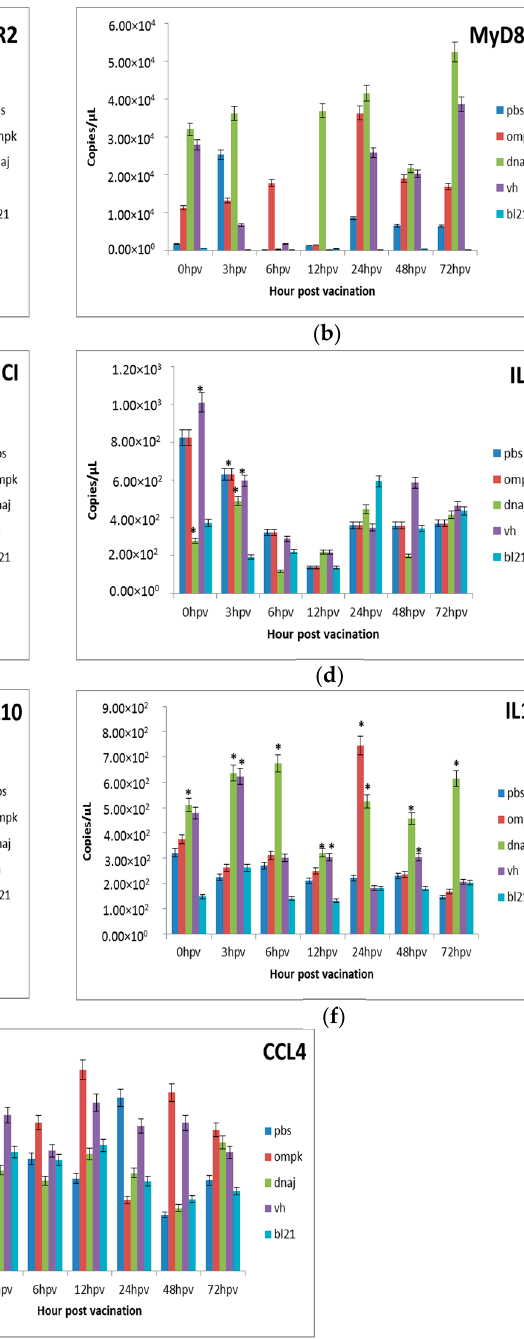
Figure 5. Comparative expression profiles of the antigen recognition-related genes ( a ) TLR2, ( b ) MyD88, ( c ) MHCI and pro-inflammatory cytokines ( d ) IL8, ( e ) IL10, ( f ) IL1ß, ( g ) CCL4 in the spleen of juvenile seabass after vaccination. Juvenile seabass were injected with 10 7 CFU / mL of the inactivated pET-32 / LIC- OmpK and pET-32 / LIC- DnaJ recombinant cells, inactivated E. coli BL21 (DE3) and formalin killed whole cells V. harveyi vaccines, while the unvaccinated control group was injected with PBS solution. Bars represent the mean copy numbers of three biological replicates and error bars represent standard deviation. Statistical significance was analyzed between the vaccinated and PBS vaccinated groups of seabass (* p <